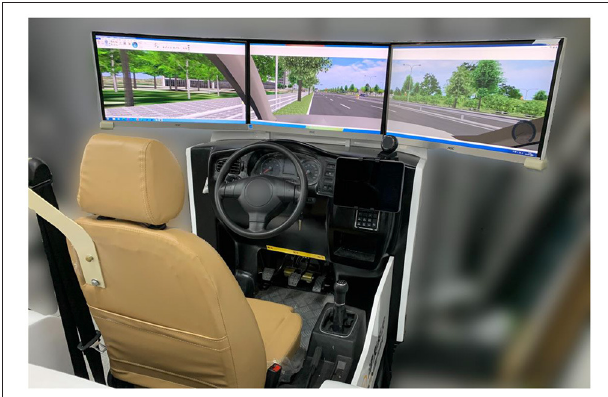
FIGURE 2 | The driving simulator used in the experiment: the condition of a physical present agent with low-level anthropomorphism.